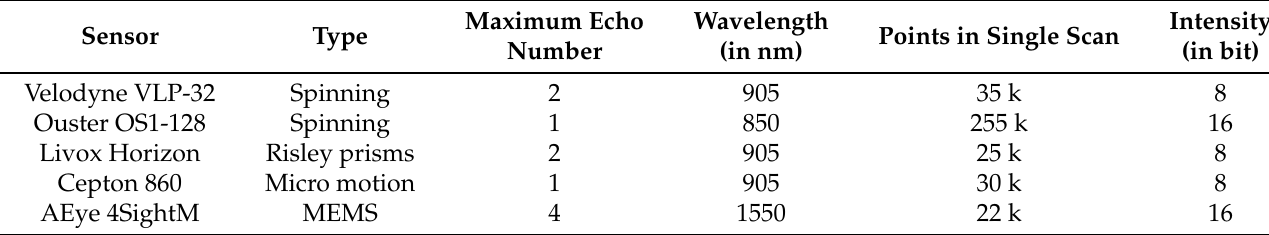
Table 3. List of lidars used during the